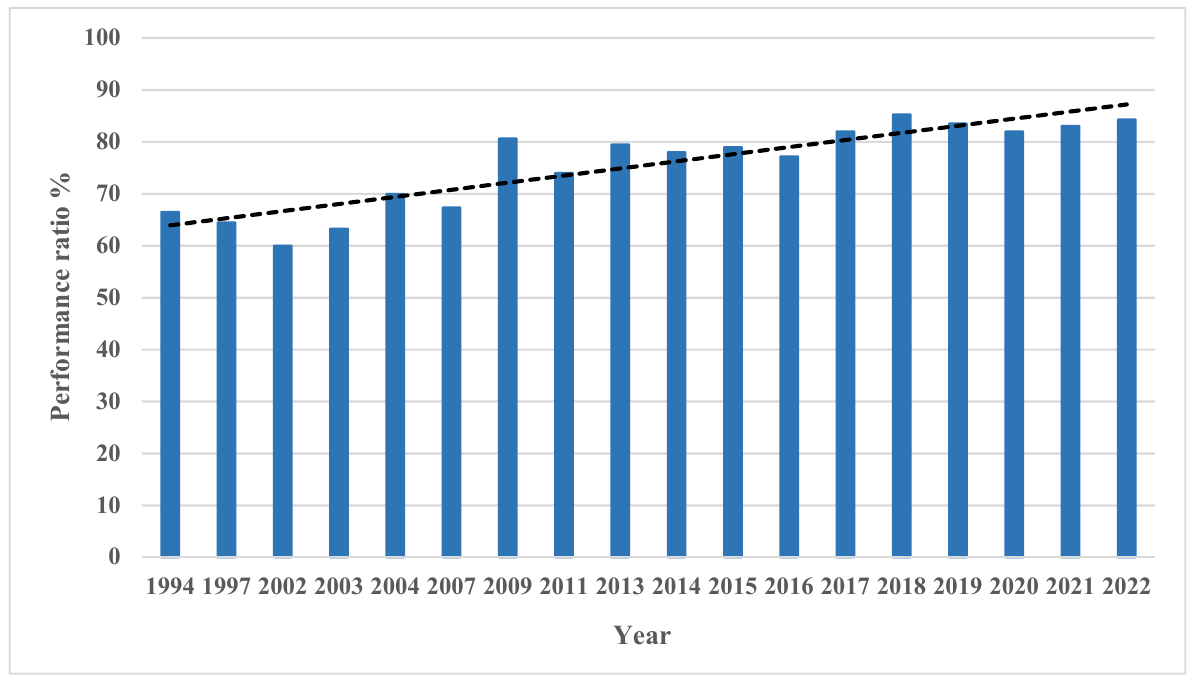
Figure 3. Performance ratio trend with respect to time (year).